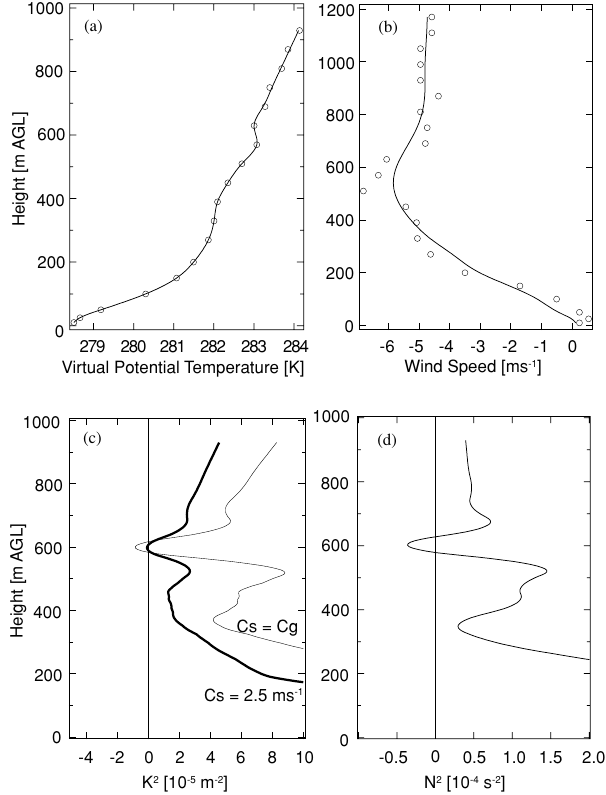
Fig. 15. Vertical structure of the lower troposphere at the MRI site. ( a ) Profile of virtual potential temperature ( θ v ) derived from tower and RASS at 00:30 JST on 30 December 1997. Open circles indi- cate actual measurements. A solid line indicates smoothed analytic function fit to the measurements. ( b ) Profile of wind speeds normal to the gravity current front (140 ◦ from north) averaged over 00:00– 00:30 JST on 30 December 1997. Open circles indicate actual mea- surements. A solid line indicates smoothed analytic function fit to the measurements. ( c ) Profiles of the squares of the Scorer param- eter ( K 2 ) at 00:30 JST on 30 December 1997. The darker line rep- resents K 2 for the solitary wave whose phase speed is 2.5m s − 1 , whereas the lighter line indicates K 2 for the solitary wave whose phase speed is equal to the propagation speed of the gravity current front. ( d ) Profile of the square of the Brunt-V¨ais¨al¨a frequency ( N 2 ) at 00:30 JST on 30 December